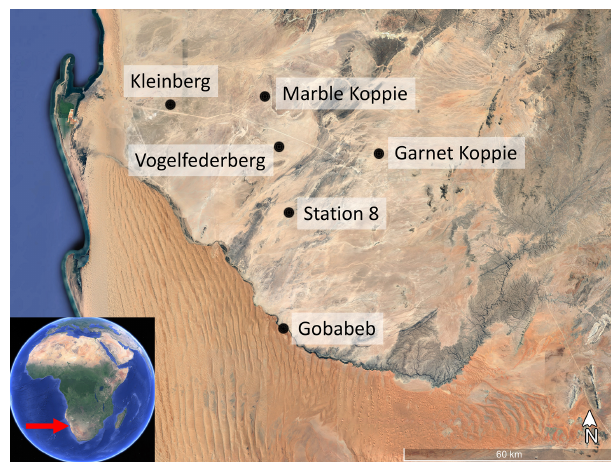
Figure A1. Location of the six FogNet sites used in this study. All samples were collected from dunes of the Namib Sand Sea at Gob- abeb. Background image © Google